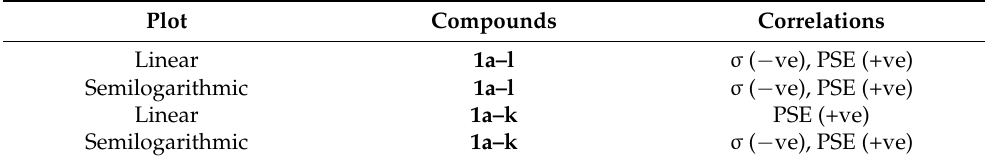
Table 3. Correlations noted ( p < 0.05) when the σ , π , and MR constants of the aryl substituents were plotted against the average CC 50 values, average SI figures, and PSE values. Plot Compounds Correlations Linear 1a–l σ ( − ve), PSE (+ve) Semilogarithmic 1a–l σ ( − ve), PSE (+ve) Linear 1a–k PSE (+ve) Semilogarithmic 1a–k σ ( − ve), PSE